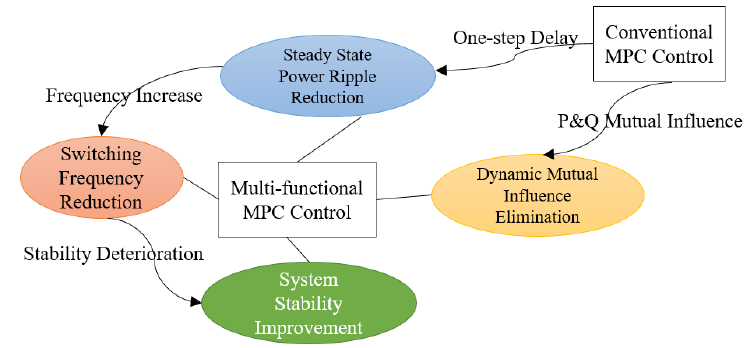
Figure 3. MMPC control design in comparison with CMPC.